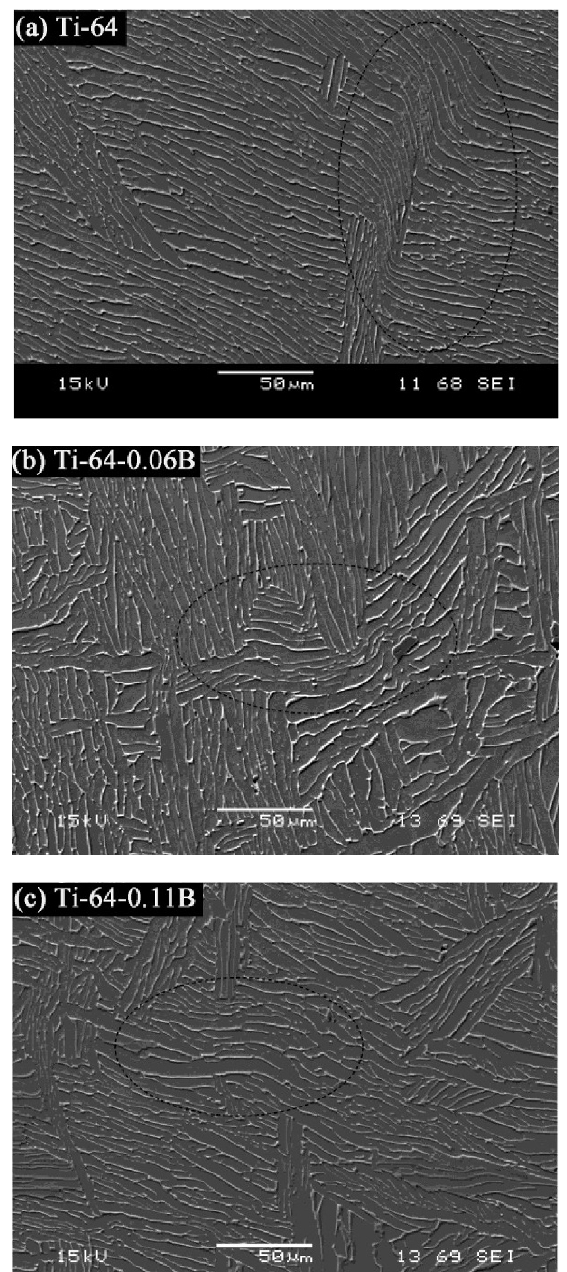
Figure 7. SEM images of (a) Ti-64, (b) Ti-64-0.06B, (c) Ti-64-0.11B, compression tested at 700°C with a strain rate of 0.001 s − 1 .